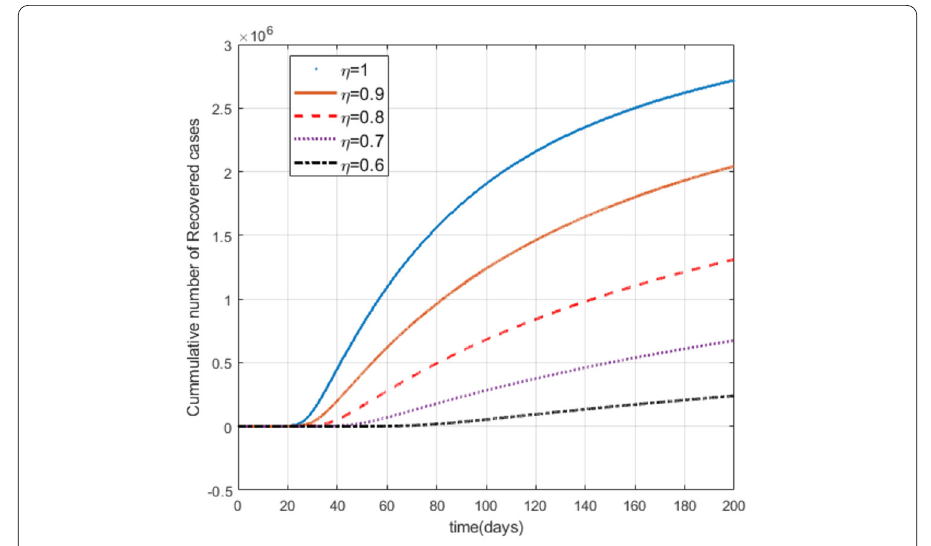
Figure 6 Total number of recovered cases (R) for different values of